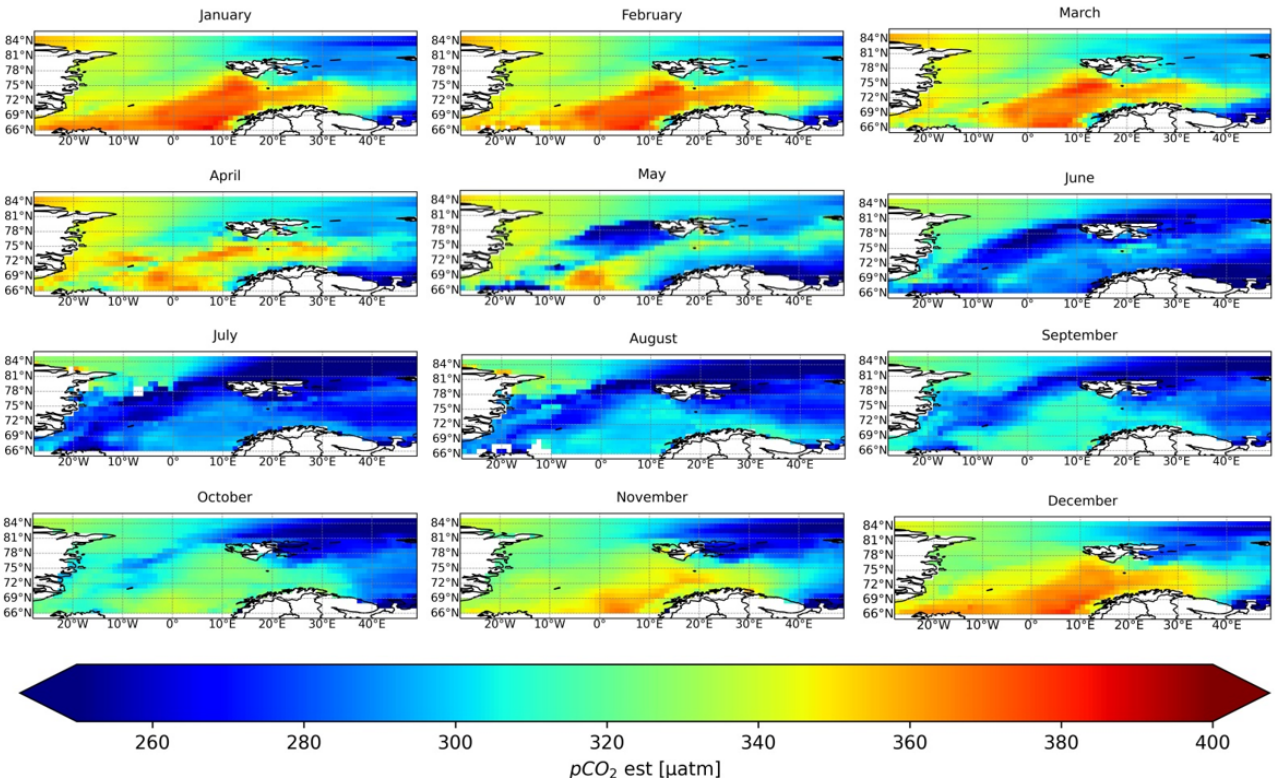
Figure 5. Five-year monthly average distribution of pCO 2W in the European Arctic Sector .